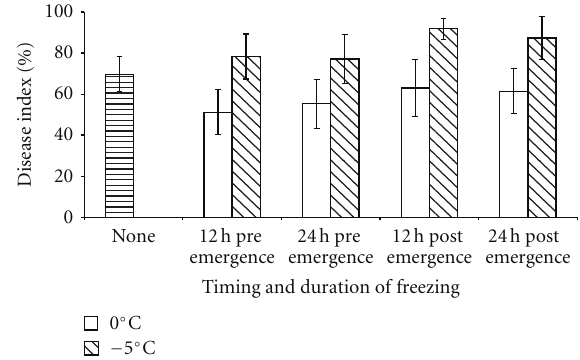
Figure 2: Disease index on seedlings grown from a winter wheat cv. Equinox seed lot naturally infected (88%) with Microdochium spp. exposed to di ff erent freezing temperatures at pre- and post- emergence. Vertical bars represent standard error.